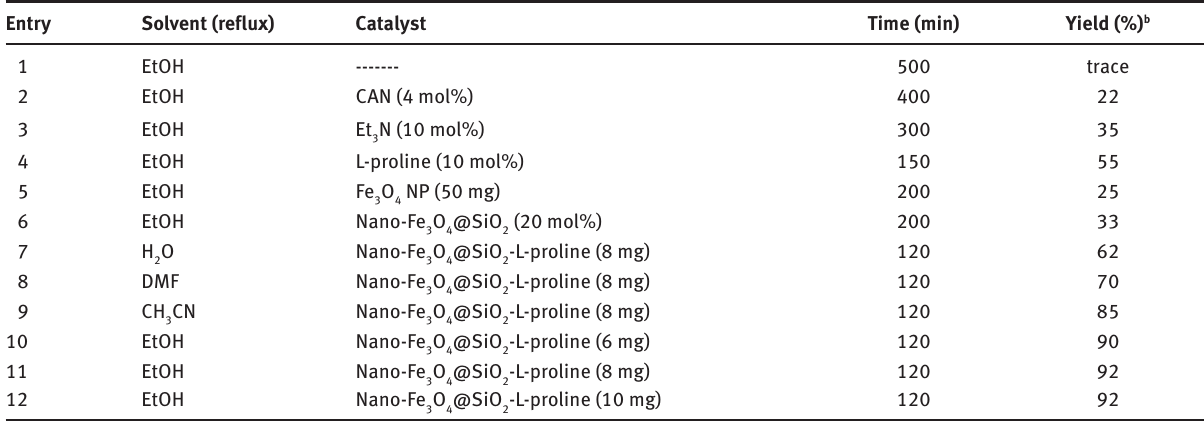
Table 1: Optimization of reaction conditions using different catalysts. a